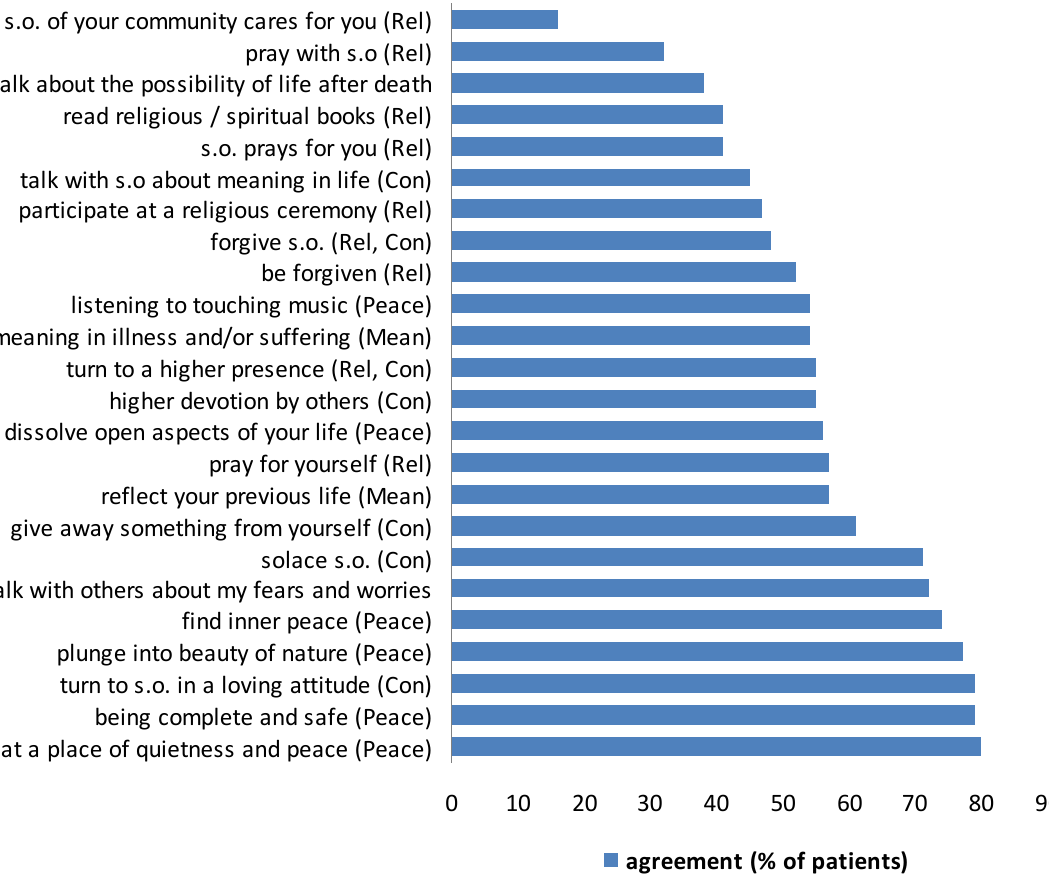
Figure 2. Spiritual needs of patients with chronic diseases as measured with the Spiritual Needs Questionnaire (SpNQ) (n = 210; 75% women, 25% men; mean age 53.7 ± 12.2 years; 67% chronic pain conditions, 28% cancer, 5% other chronic diseases